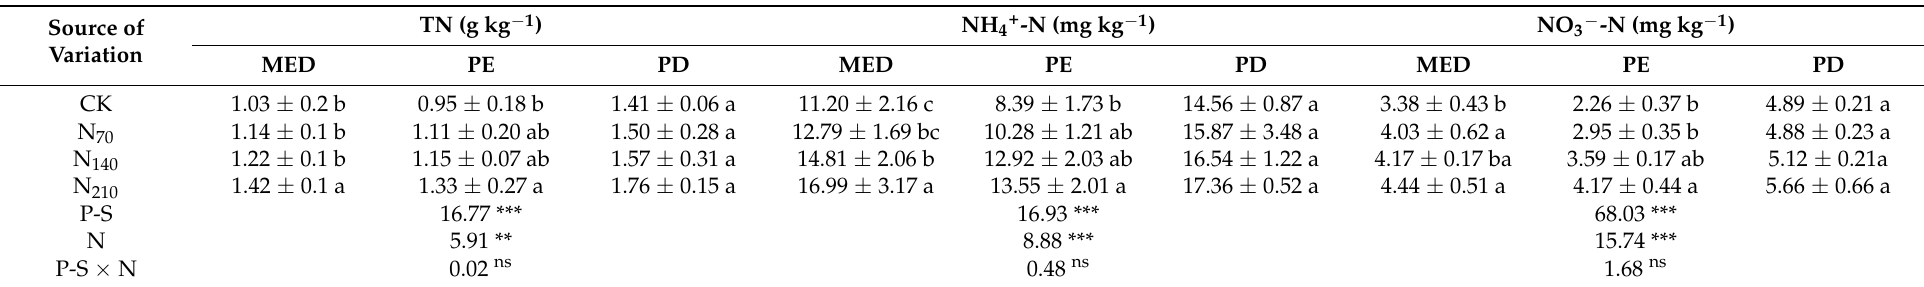
Table 3. The mean values of TN, NH 4+ -N and NO 3 − -N concentration in the soil as a result of planting system (P-S), N level (N) and their interaction after 4 years under field conditions. Source of